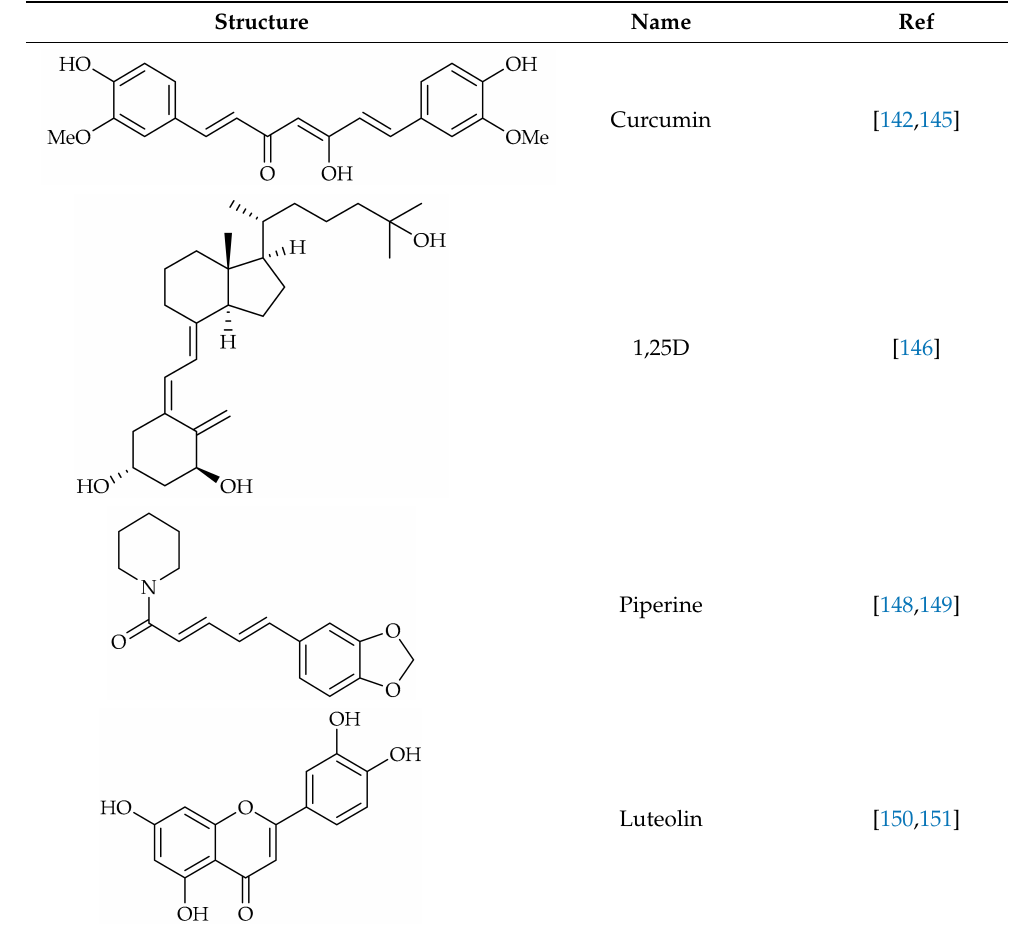
Table 5. Structure of nutraceuticals studied for the treatment of